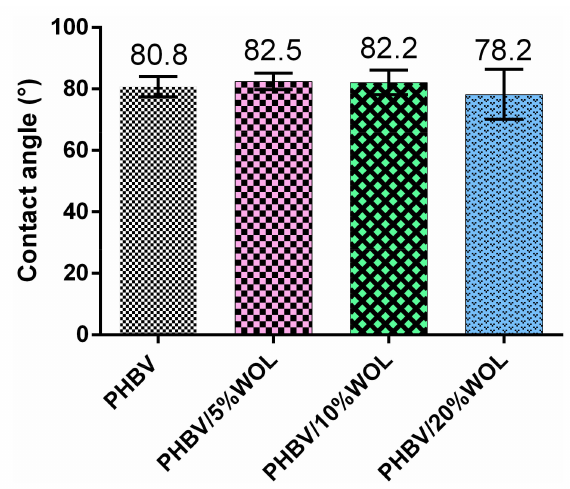
Figure 7. Contact angle values of neat PHBV, PHBV / 5%WOL and PHBV / 10%WOL films.